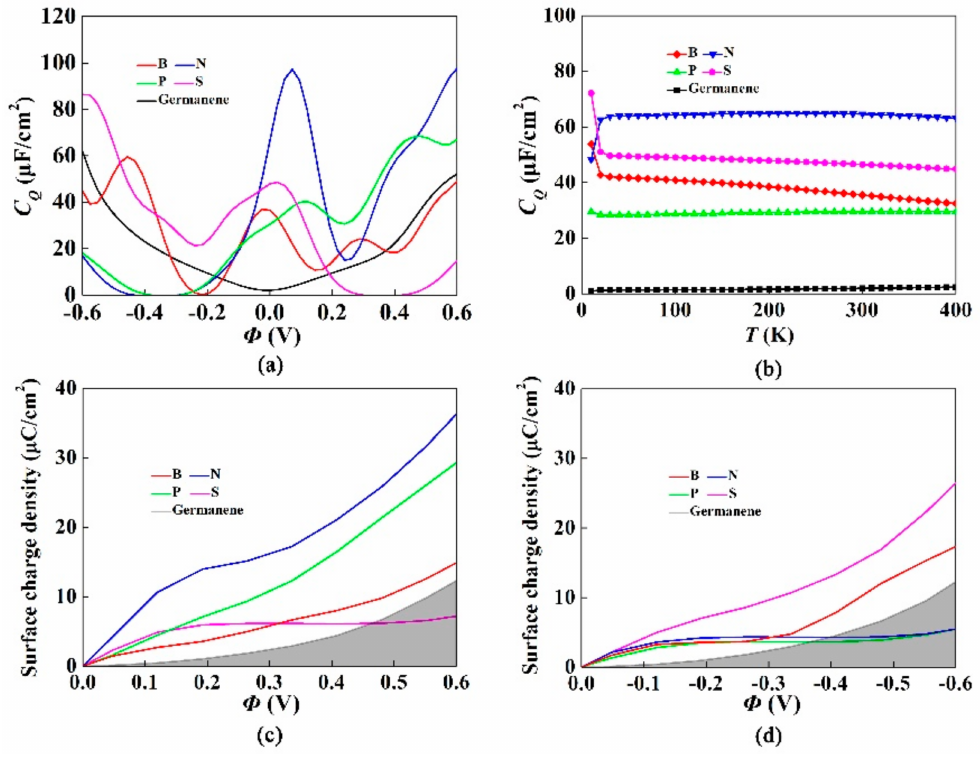
Figure 3. ( a ) Calculated quantum capacitance of the triple-B (N, P, S) doped with single-vacancy germanene; ( b ) Change of C Q with temperatures in the scope of 0 K–400 K, the consequences gained in 4 × 4 supercell with a doping concentration of 9.4%; ( c , d ) Surface charge density vs. Φ between − 0.6 V and 0.6